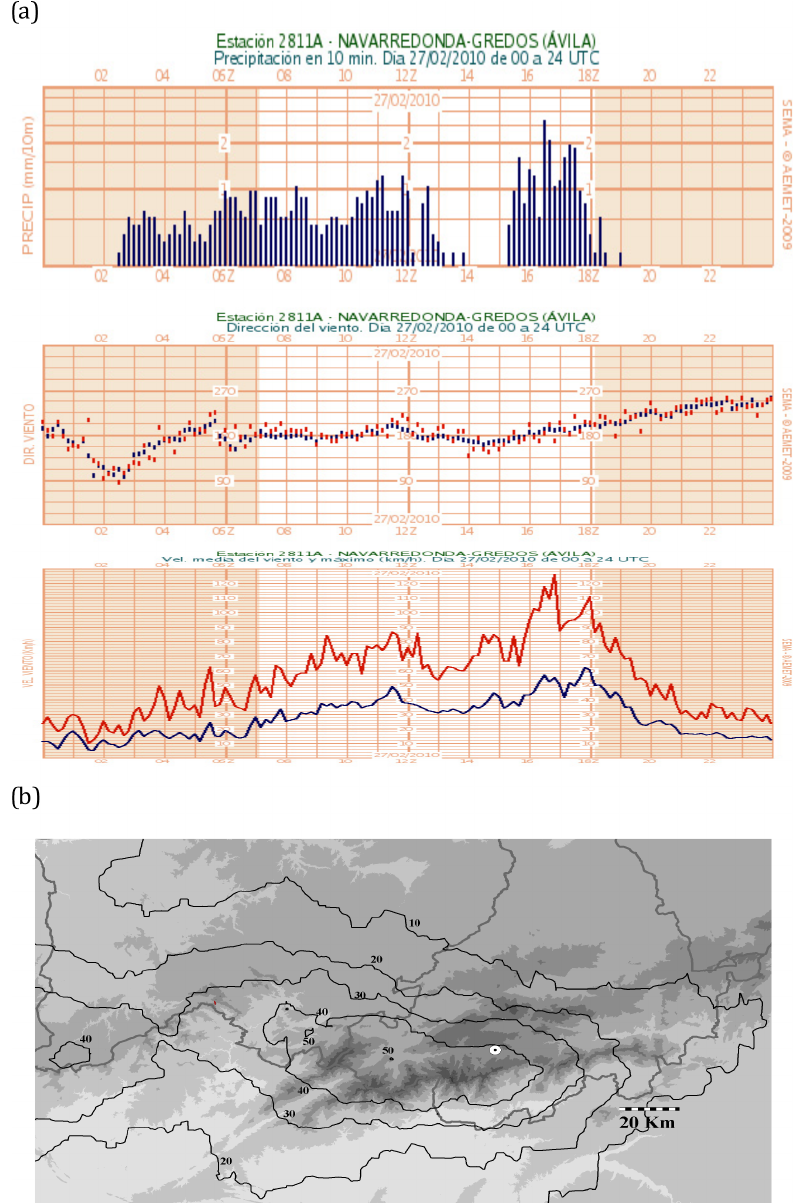
Figure 9. (a) Temporal distribution of precipitation, wind direction, and wind intensity (maximum and mean) on 27 February observed at the weather station at Navarredonda (see Fig. 1b); (b) spatial pattern of precipitation (isolines in mm) observed on 27 February over the study area (circle, Navarredonda automatic weather